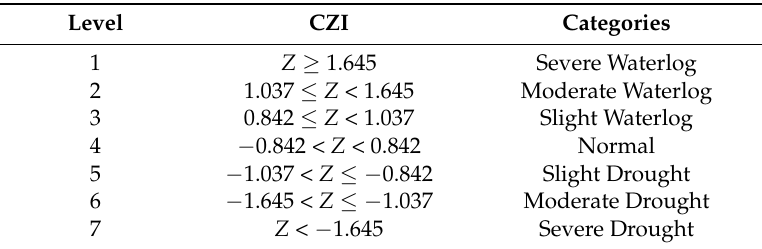
Table 1. The drought and waterlog category of